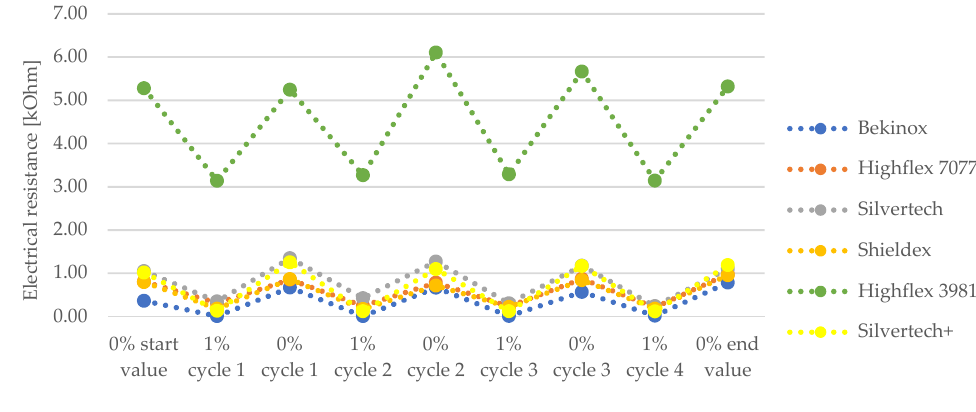
Figure 8. Change of electrical resistance of various carbon-silicone coated substrates upon loading and unloading, showing the working principle of the sensory yarn as electrical resistance decreases upon 1% loading.